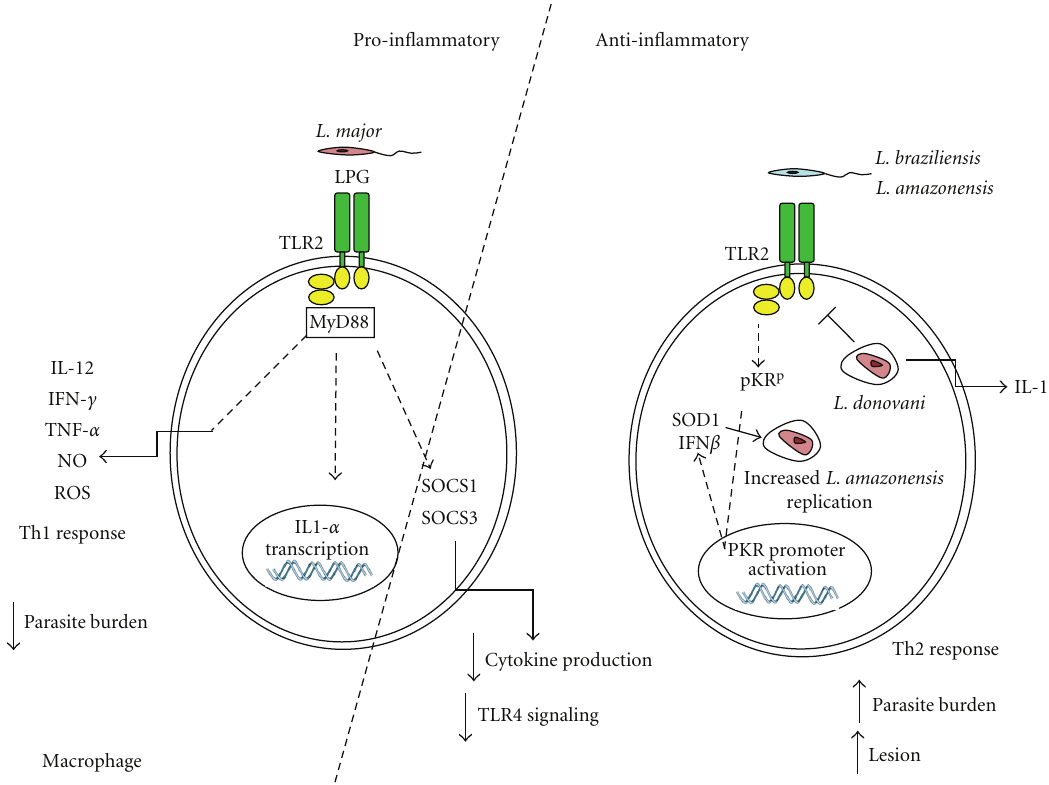
Figure 1: Model for the activation of TLR2 by Leishmania sp. , leading to a proinflammatory (left), or anti-inflammatory arm (centre and right). In early studies, L. major stimulated the transcription of IL1 α through a MyD88-dependent pathway, but not the IL1 α production at the protein level, suggesting the triggering of anti-inflammatory stimuli negatively controlling IL1- α production [22]. LPG or additional undefined TLR2 ligands promote the synthesis of cytokines, nitric oxide (NO), and reactive oxygen species (ROS) that are related to parasite killing and to the development of a protective Th1 response, through MyD-88-dependent pathways [22–29]. L. major LPG also induces the production of suppressors of the cytokine signaling family proteins SOCS-1 and SOCS-3 [26], whose activities are associated with diminished cytokine production and prevention of TLR4 signaling [30]. Lack of TLR2 increased the resistance to infections with L. braziliensis [31] and L. amazonensis [32] decreased lesion formation and parasite burdens, suggesting that TLR2 is required for disease promotion. In RAW macrophages, the infection with L. amazonensis promotes the phosphorylation of PKR and the activation of the PKR promoter and enhances the synthesis of both PKR and of type 1-IFNs, and those events require TLR2 [33]. The levels of SOD1 expression are elevated in association with PKR activation and IFN β production, resulting in increased parasite replication [33]. L. donovani downmodulates TLR2 responses in macrophages by inhibiting MAPp38 kinase, leading to IL10 production [34]. The dashed lines indicate that intermediate steps of the pathways are either not identified or not represented in the